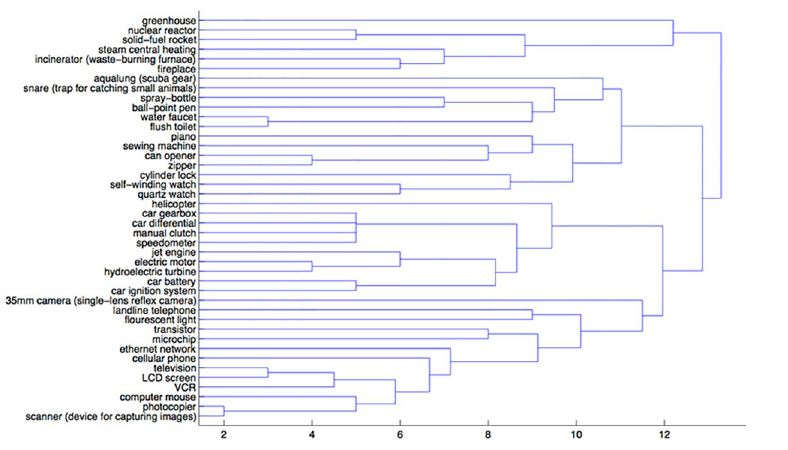
Fig 1. A dendrogram representing the mechanism condition sortings.